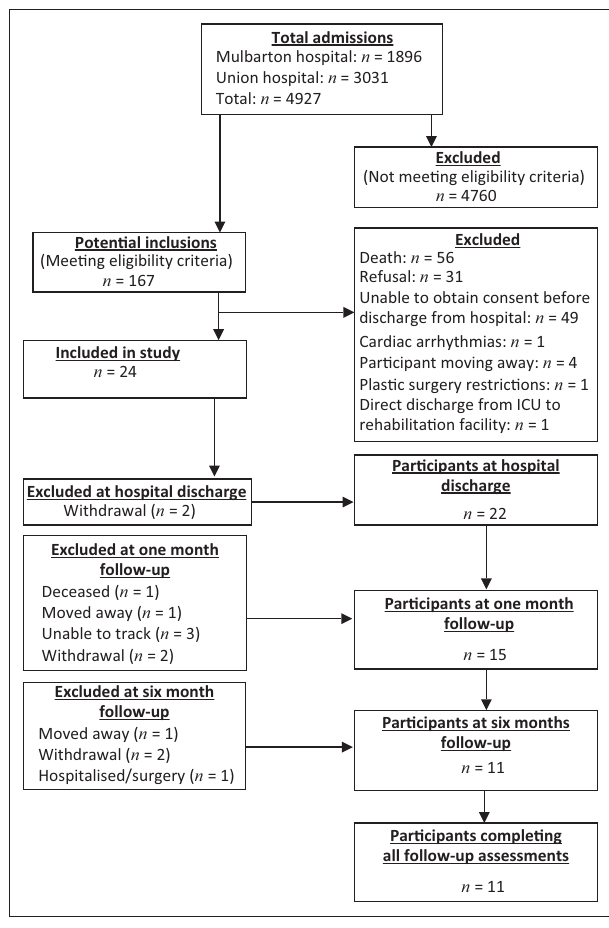
FIGURE 1: Flow of participations throughout the